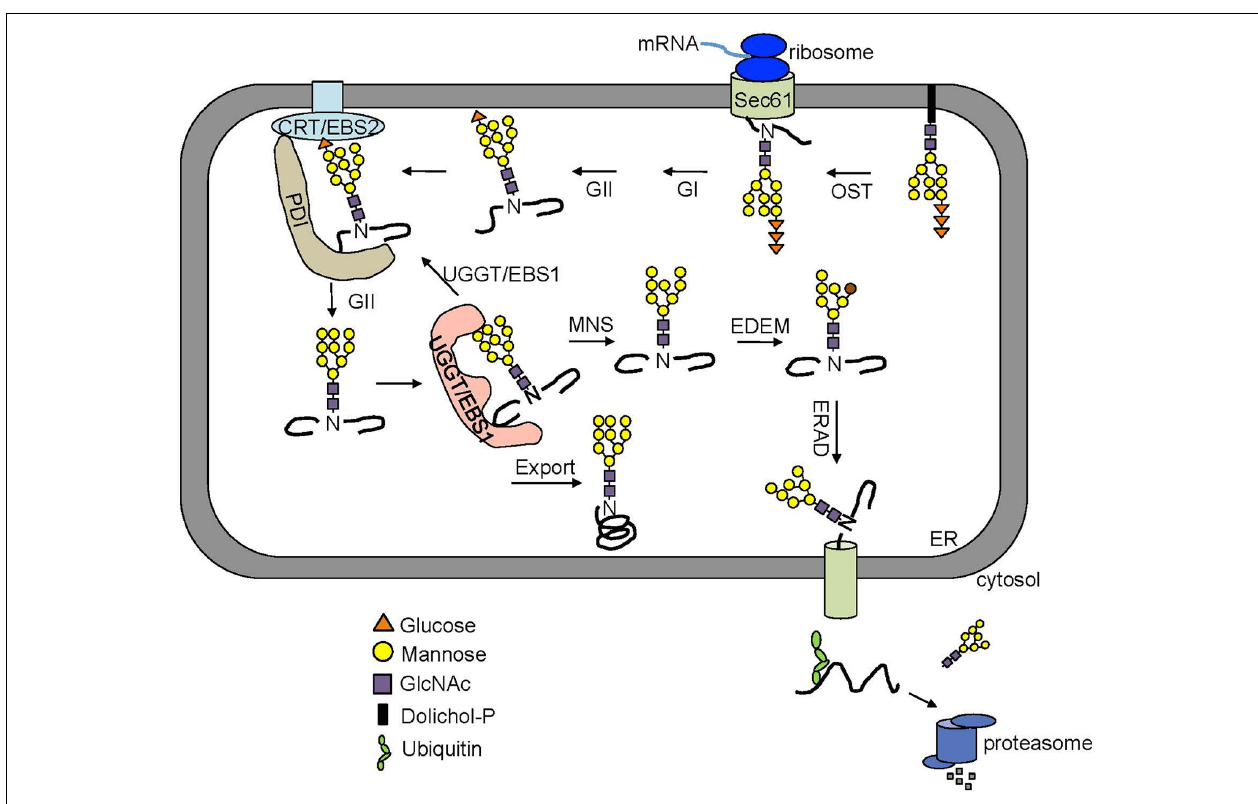
EBS1 in Arabidopsis ) that adds back a Glc residue to the A branch, permitting its reassociation with CNX/CRT. A glycoprotein that fails to gain its native structure within a certain time window is removed from the folding cycle via sequential trimming of the two terminal α 1,2 Man residues of the B and C branch by MNS1 (an ER-localized α 1,2-Mannosidase, known as MNS3 in Arabidopsis ) and Htm1/EDEM. A terminally misfolded glycoprotein with α 1,6 Man-exposed glycan is selected to enter the ERAD